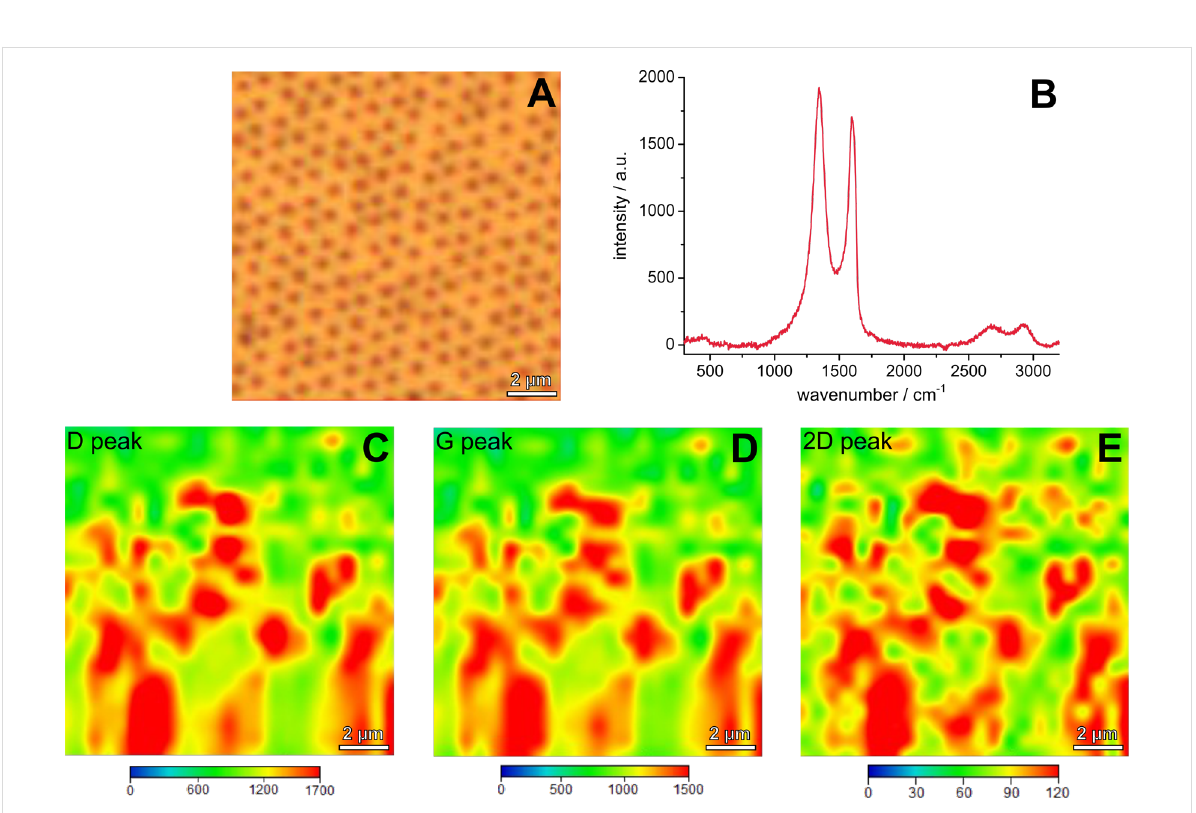
Figure 5: Microscopic image (A), exemplary Raman spectrum (B) and Raman maps (C–E) of the sensor slide consisting of rGO on a nanohole array with a D / P ratio of 0.43. The maps show the Raman intensity of the D-peak at 1345 cm − 1 (C), the G-peak at 1603 cm − 1 (D) and the 2D-peak at 2682 cm − 1 (E) on the area shown in the microscopic image